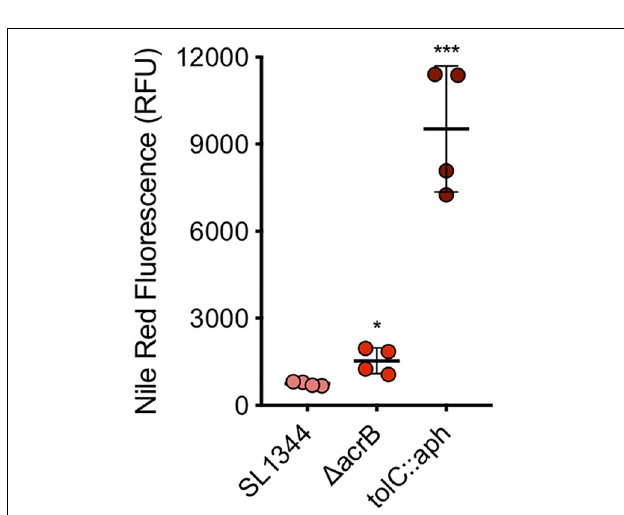
FIGURE 6 | Accumulation of nile red in WT, (cid:49) acrB and tolC::aph in S. Typhimurium. Single circles represent the X-median value of nile red fluorescence from 10,000 cells within a biological replicate using WT (pink), (cid:49) acrB (red) and (cid:49) tolC (dark red). 4 biological replicates for each strain are shown, with a long bar to show the mean and SEM error bars. Significance values were based on an unpaired T -test comparing the efflux deficient strain to WT. ∗ and ∗∗∗ correspond to P -values shown in Supplementary Table S3 .